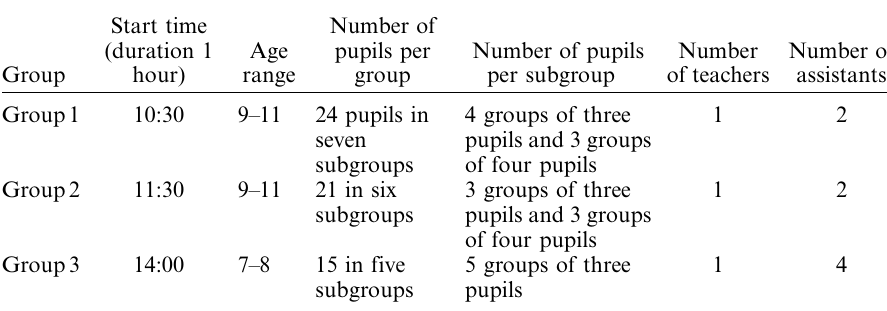
Table 1. The distribution of pupils, teachers and parental assistants across the three groups undertaking the photo marathon activity during a one day school visit in October 2010.